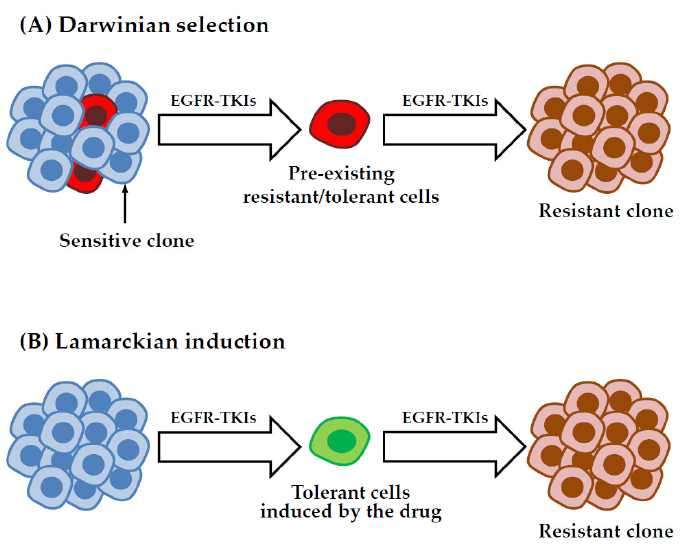
Figure 3. Models for the emergence of drug-tolerant cells. In the pre-existing selection model ( A ), DTP cells are selected in response to treatment because of some intrinsic properties through non- genetic Darwinian selection. Alternatively, in the drug induced model, also known as Lamarckian induction ( B ), DTP cells can originate more randomly as a direct effect of the treatment. These cells can evolve over time to acquire various genetic or non-genetic mechanisms of resistance.